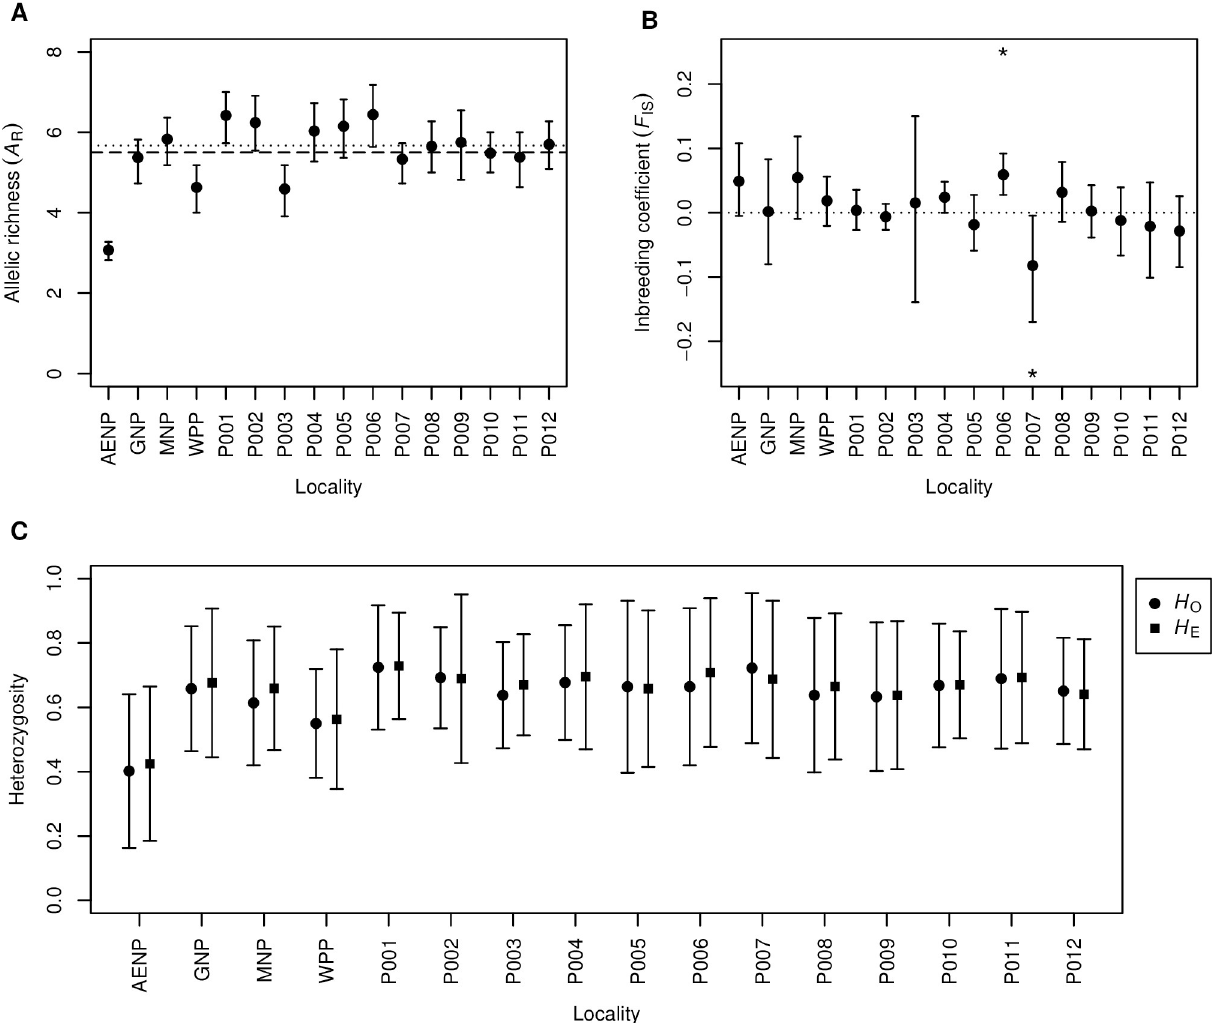
Fig 1. Genetic diversity indices of the 16 sampling localities analysed in the present study. A Allelic richness, where the mean is shown by the dashed line and the mean without AENP is shown by the dotted line. B Inbreeding coefficient, where an asterisk ( � ) indicates significant deviation from zero (dotted line). C Observed ( H O ) and expected ( H E ) heterozygosity. Vertical bars indicate 95% confidence intervals on plots A and B, and standard deviation on plot